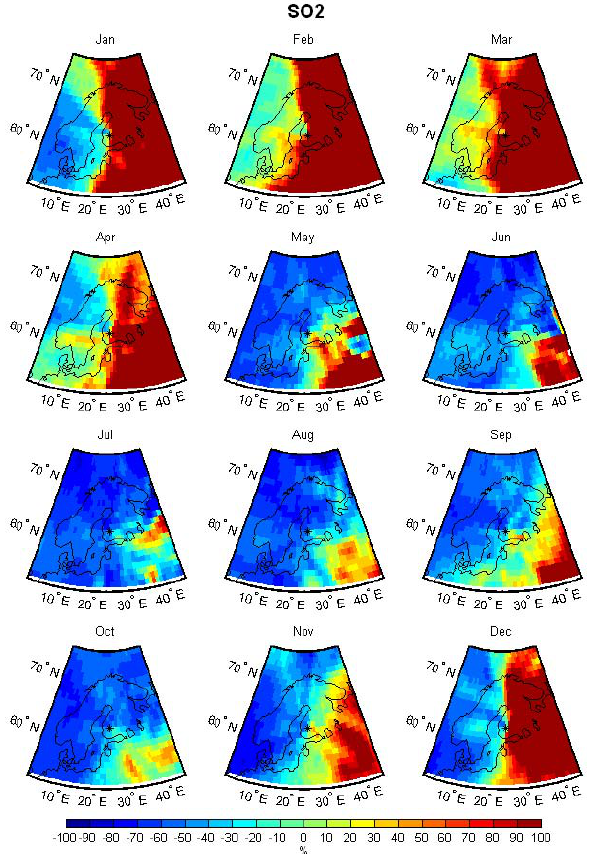
Fig. 7. Deviation from measured average SO 2 concentration in Hyyti¨al¨a according to transport directions. Monthly concentration fields are produced for years 1996–2008. Fields are normalized to the geometric mean concentration (0.18 ppb) of the whole measure- ment period. Hyyti¨al¨a is marked with a